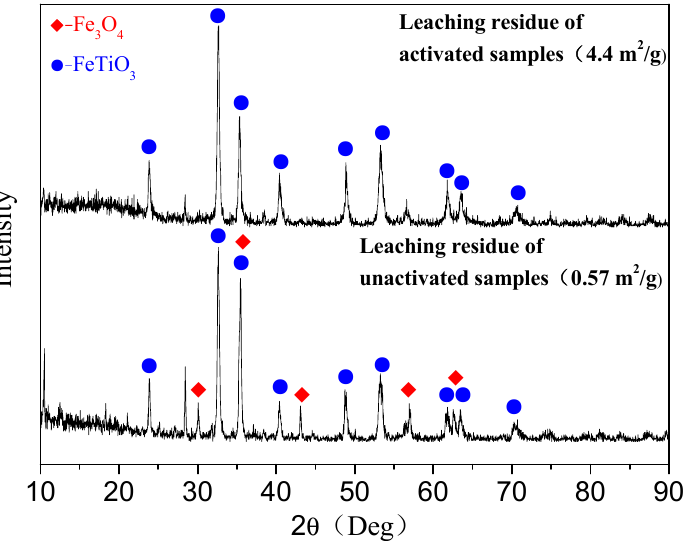
Figure 8. Rate of iron and titanium dioxide extractions with different mechanical activation times.